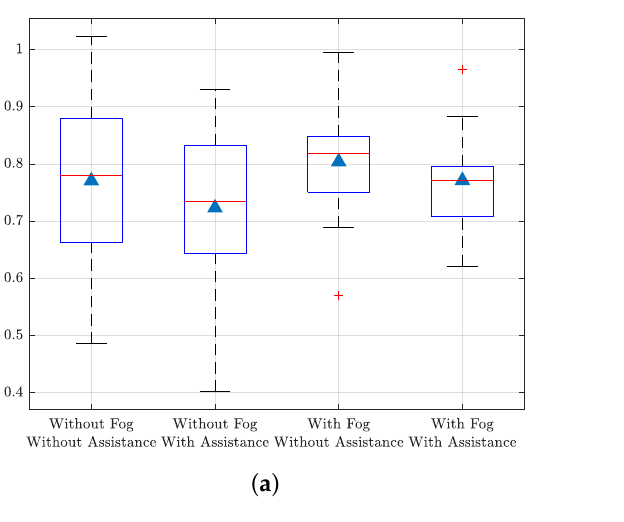
Figure 7. Lane-keeping performance: ( a ) mean of adjusted deviation of the lateral position and ( b ) standard deviation of the lateral position.